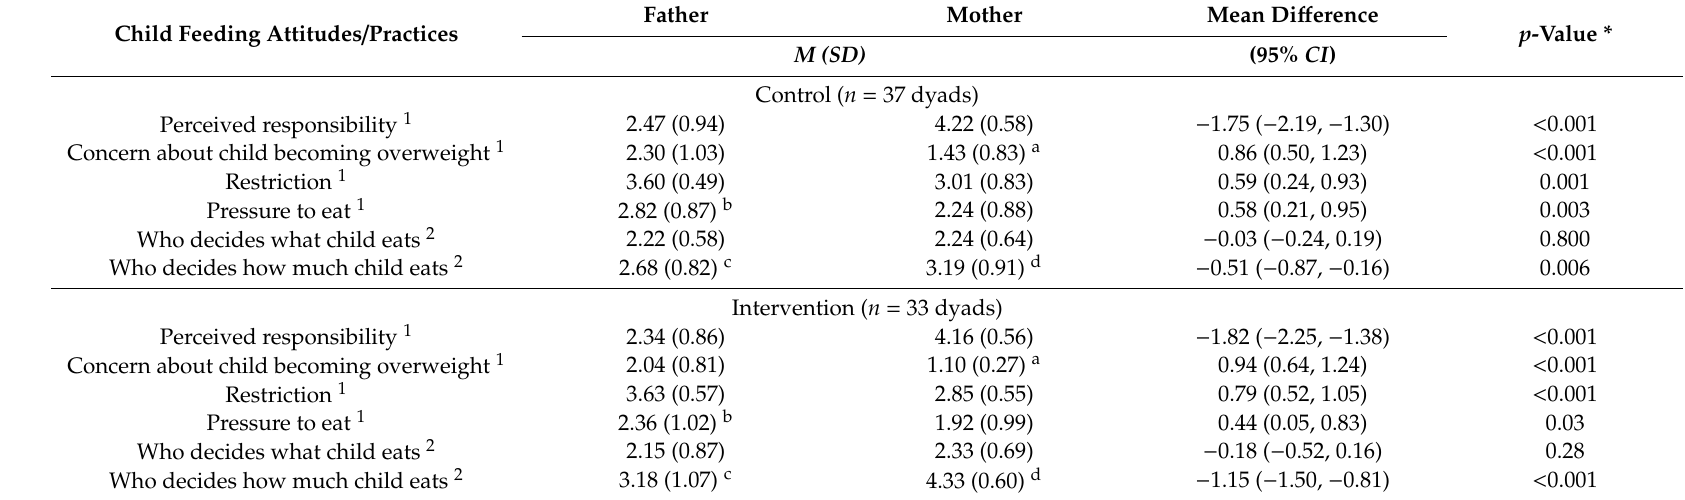
Table 2. Fathers’ versus mothers’ ( N = 70 dyads) self-reported feeding attitudes and practices 1,2 ( M , SD ) stratified by NOURISH group allocation (control vs. intervention)